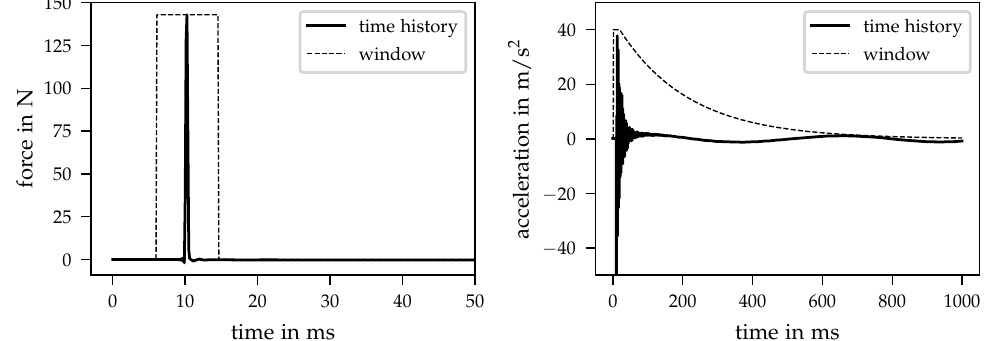
Figure 4. Applied window functions and example time histories. ( left ) Time history and win- dow function for excitation/force signal. ( right ) Time history and window function for re- sponse/acceleration